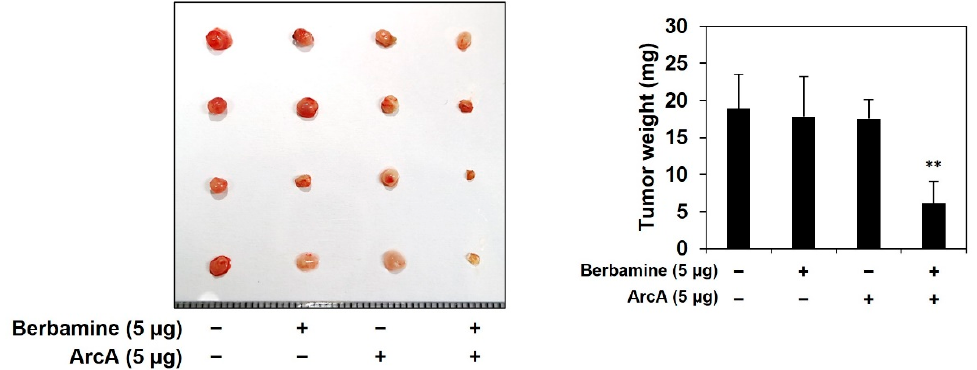
Figure 6. Combined treatment of berbamine and ArcA potently suppresses tumor growth derived by GSCs in vivo. Fertilized chick eggs were incubated in a humidified incubator at 37 ◦ C. At embryonic day seven, U87MG-derived GSCs were mixed with ECM gel in the absence or presence of the indicated compounds (5 μ g/egg) and were grafted onto the CAM surface. Seven days later, the CAMs were observed, the formed tumors were retrieved, and the tumor weight was calculated. ** p < 0.01 vs. the compound alone.